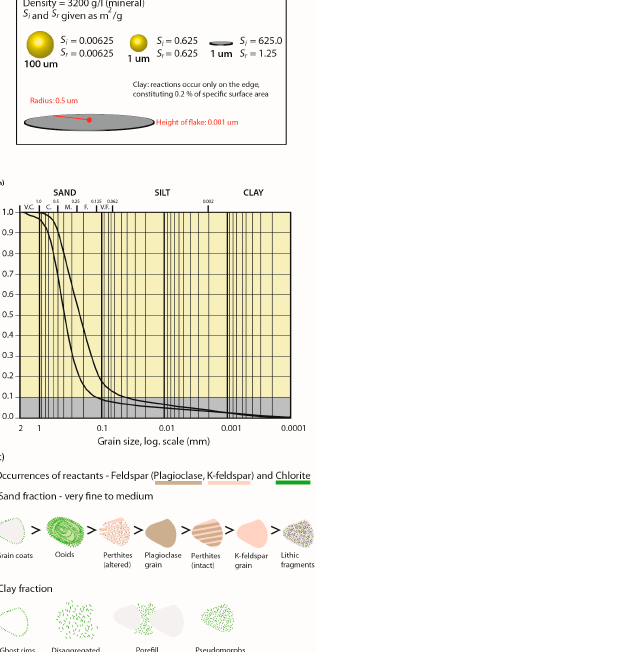
Figure 5. Parameterization of reactive surface areas: ( a ) Examples of grain geometries in relation to specific and reactive surface areas. For platy clay minerals S r << S i , as reactions only occur along the edges; ( b ) Grain size distribution curves for typical lower (finer) and upper (coarser) shoreface facies. The small amounts of clay in reservoir sandstone and small amounts of available sample material